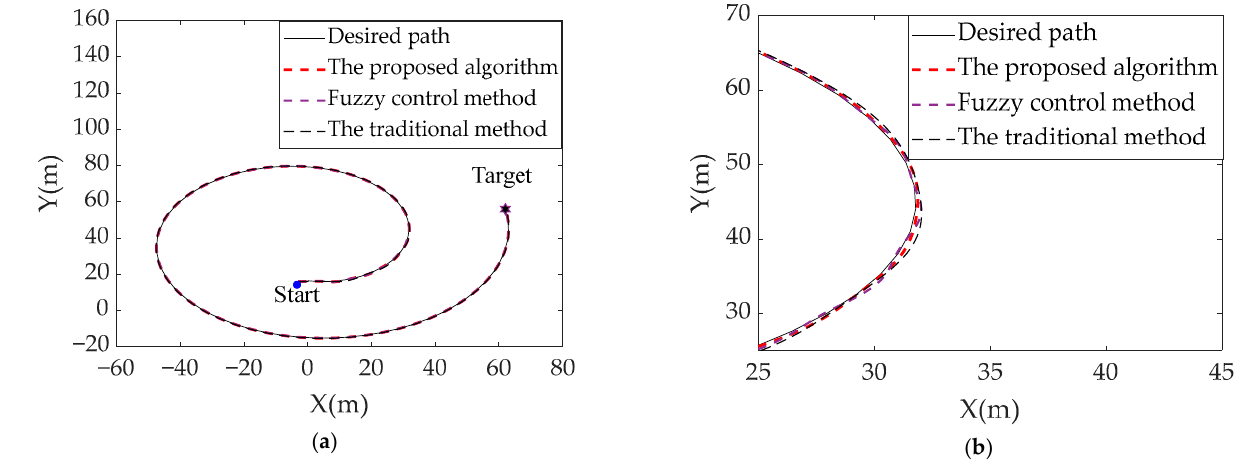
Figure 17. ( a ). Path-tracking results for Archimedean spiral. ( b ) Partial enlargement for the track- ing path.